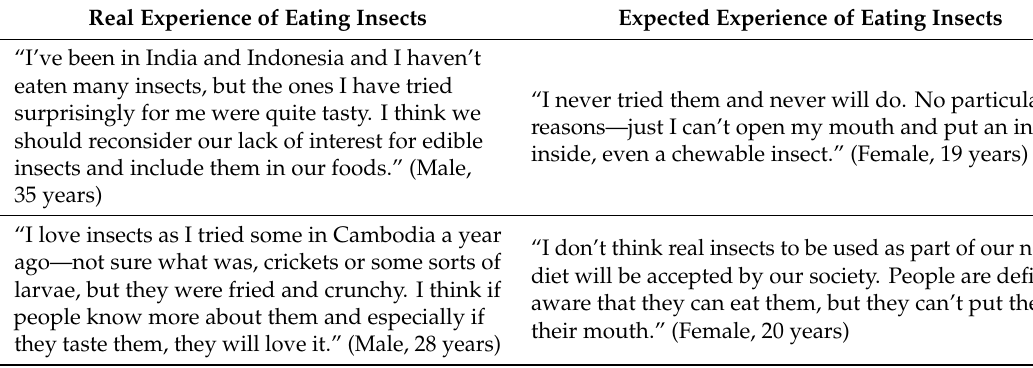
Table 3. Tasting factors: real experience versus imagination of eating